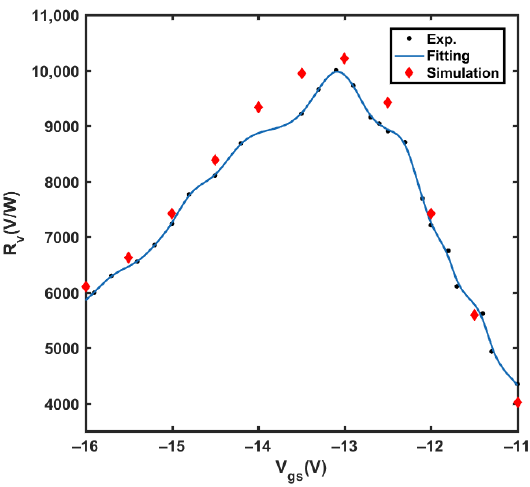
Figure 10. The experimental and simulation results of responsivity with the change of V gs .